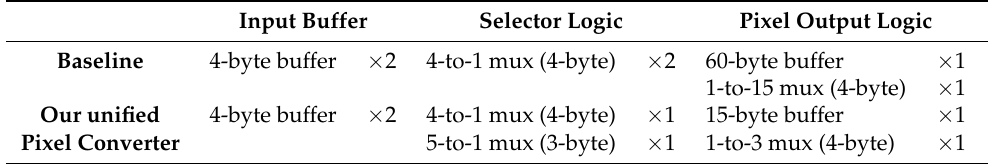
Table 3. Component configuration.